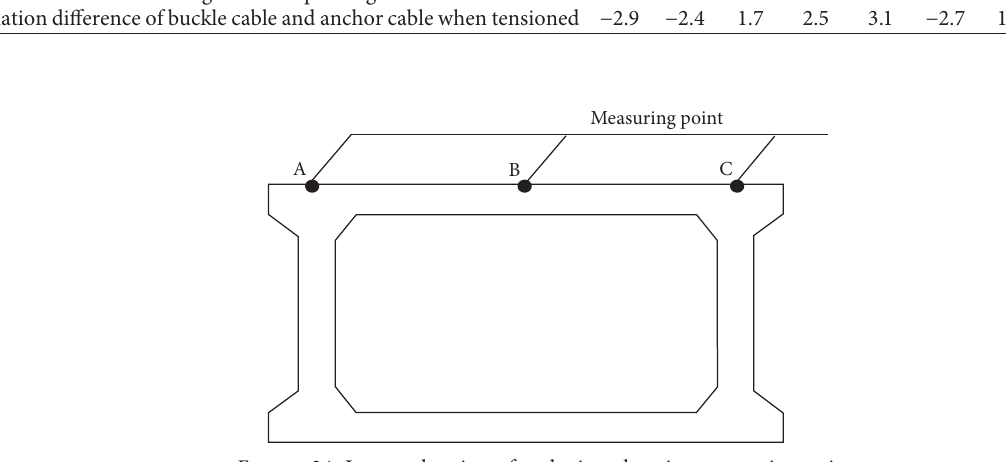
Deformation difference of buckle cable and anchor cable when tensioned − 2.9